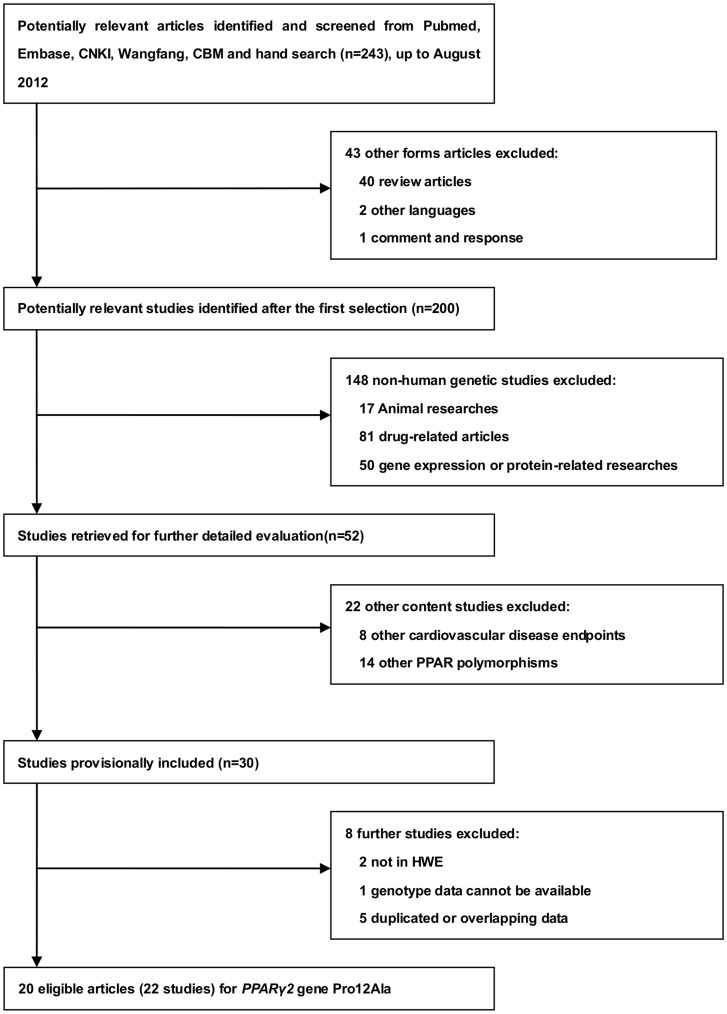
Flow diagram of search strategy and study selection for the meta-analysis.